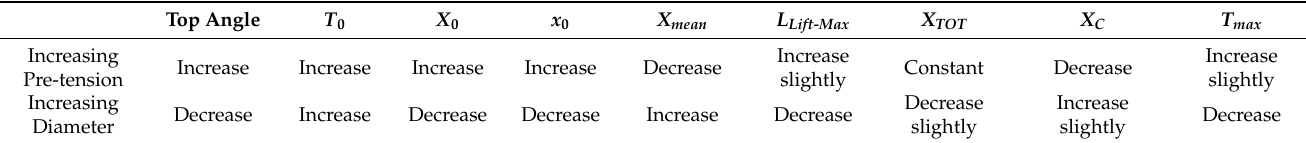
Table 17. Effects of pre-tension and diameter of the cable on the response of the system.